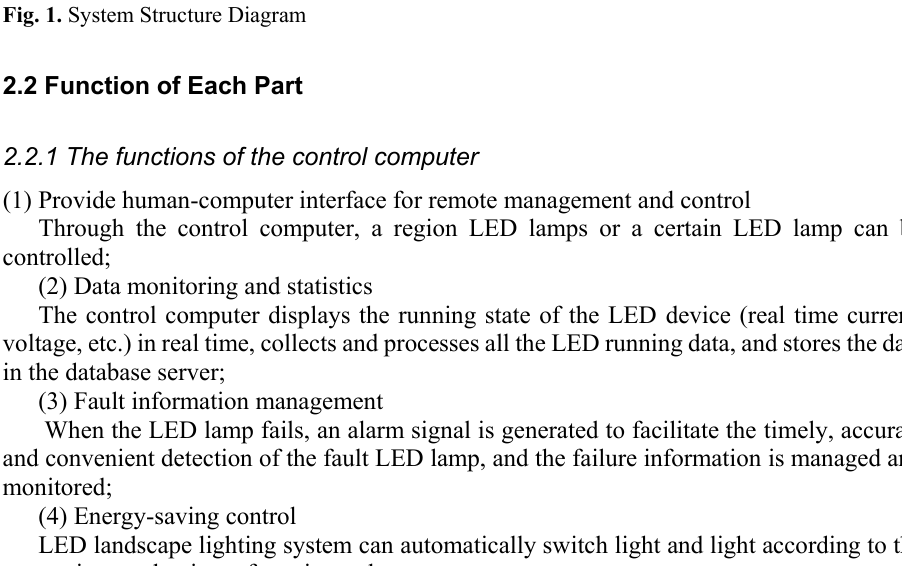
Fig. 1. System Structure